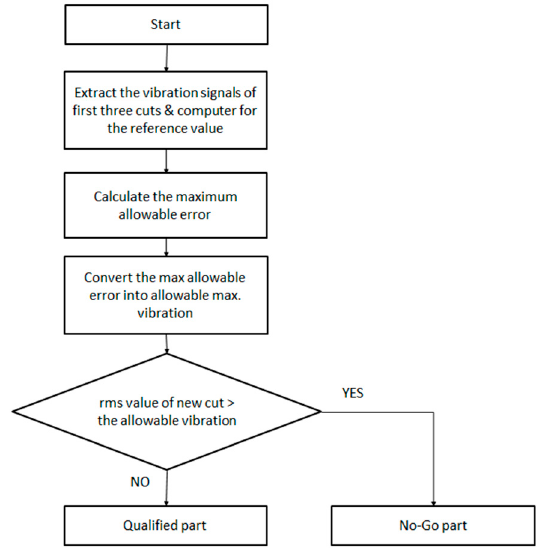
Figure 11. Flowchart of on ‐ machine dimension inspection.